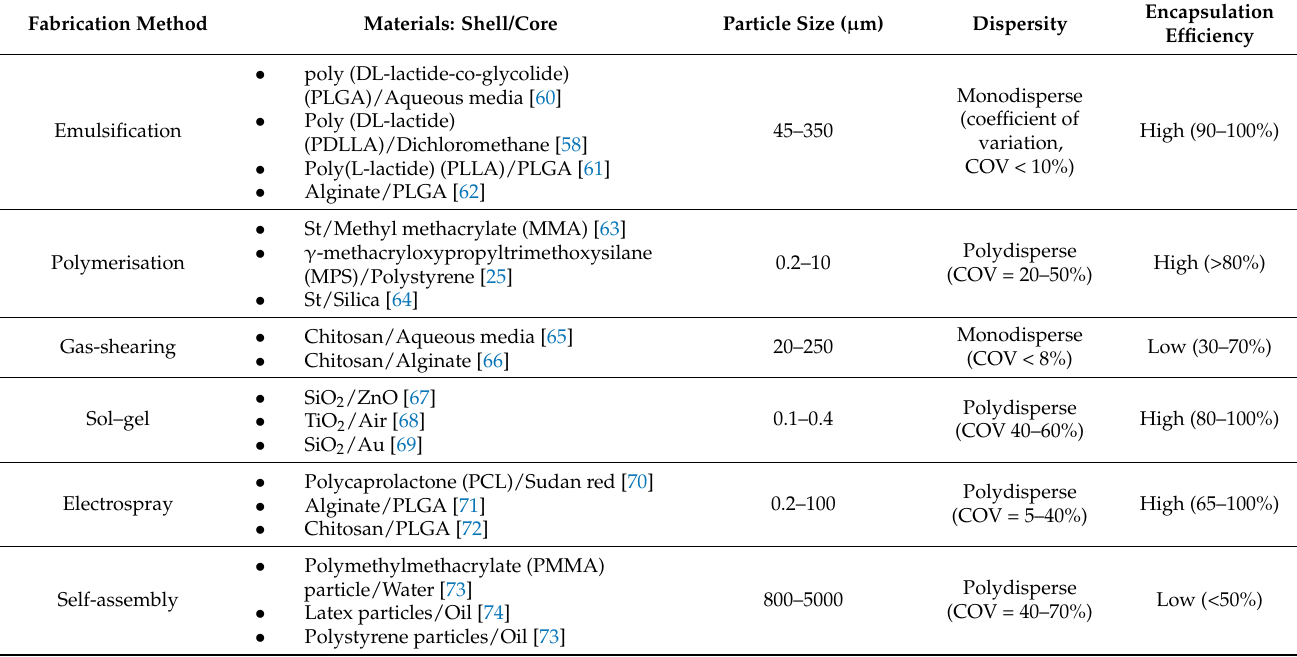
Table 1. Comparison of various fabrication methods for core–shell